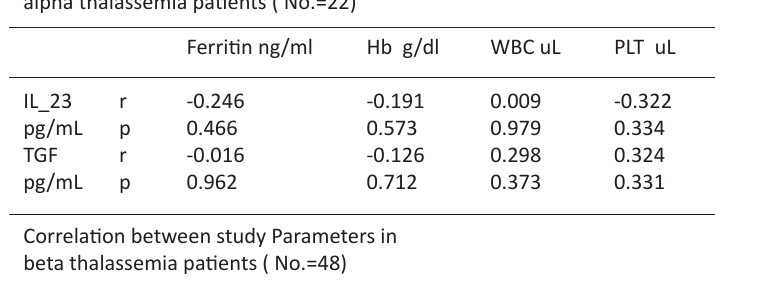
Correlation between study Parameters in beta thalassemia patients (